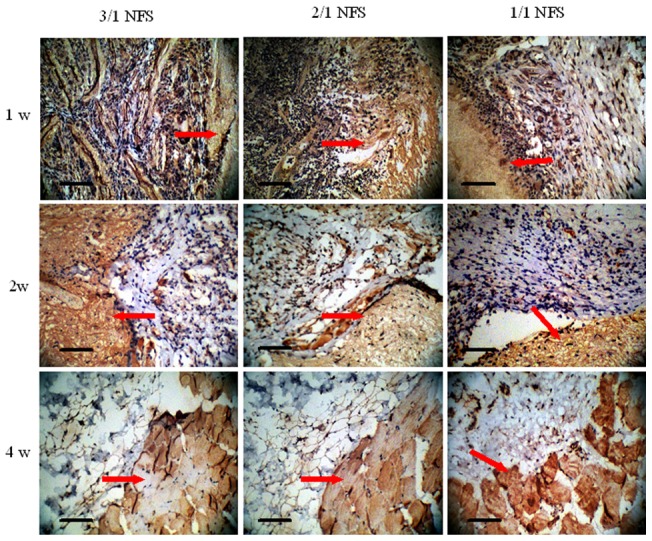
The expression of CD68 by immunohistochemistry in inflammatory reaction caused by NFS.Scale bar  = 100 μm. CD68 is a representative factor which expresses positively in non-specific inflammation mediated by macrophagocyte. The red arrows indicate the NFS debris embedded in paraffin sections which stained to be light brown. At 1w after NFS implanting into subcutaneous pockets of SD rats, the all three type NFS were surrounded by a large number of CD68+ macrophagocytes showed purple. As the time passed by, the purple macrophagocytes decreased, and then vanished, which meant the inflammation reaction ended.